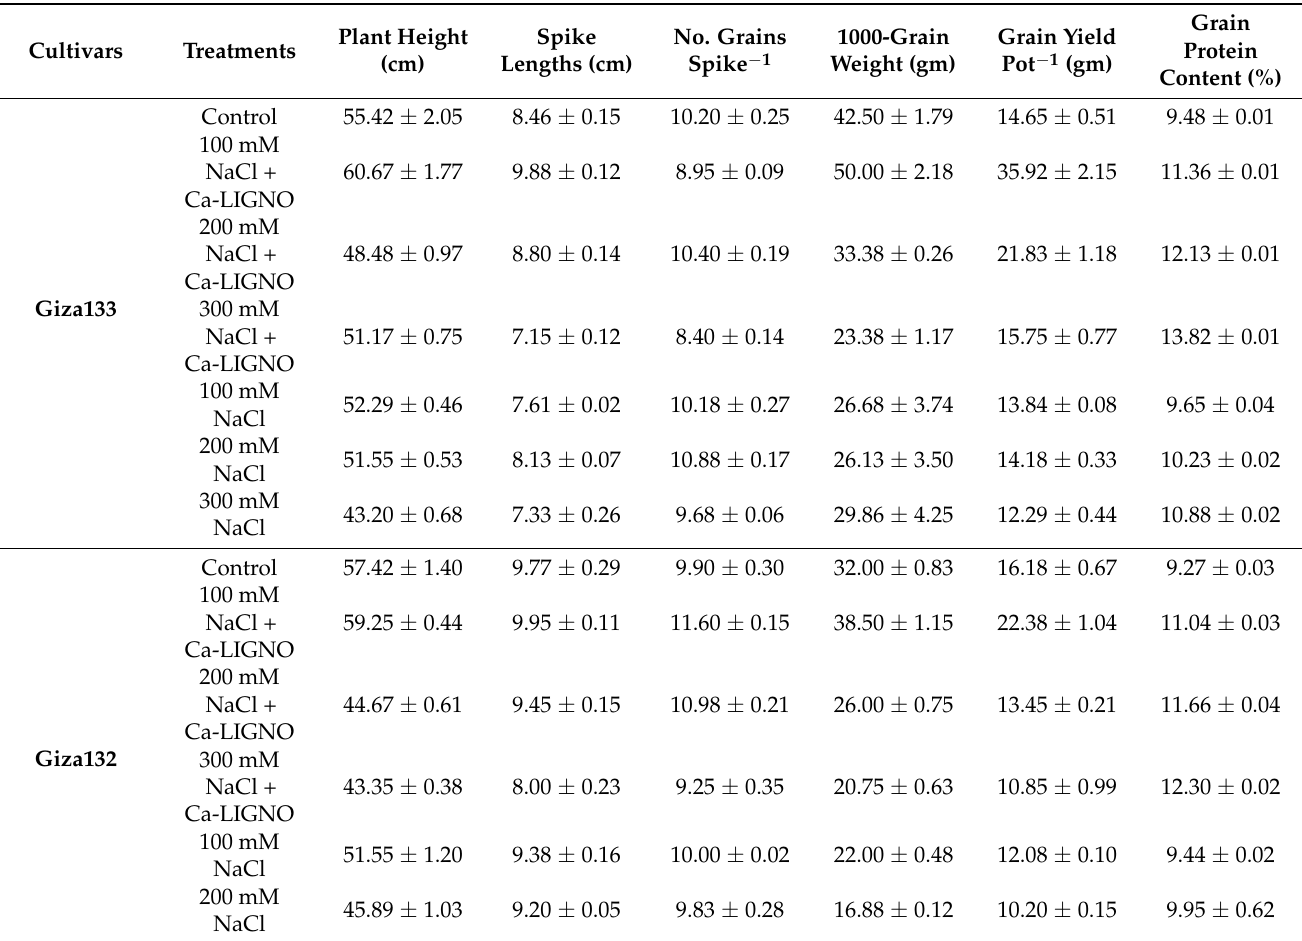
Table 6. Plant height, spike length, number of grains spike-1, grain yield pot-1, 1000-grain weight, and grain protein content of Giza133 and Giza132 barley cultivars under various treatments: (control, NaCl concentrations, and NaCl concentrations + Ca-LIGNO) during two seasons, 2019/2020 and 2020/2021, in combined